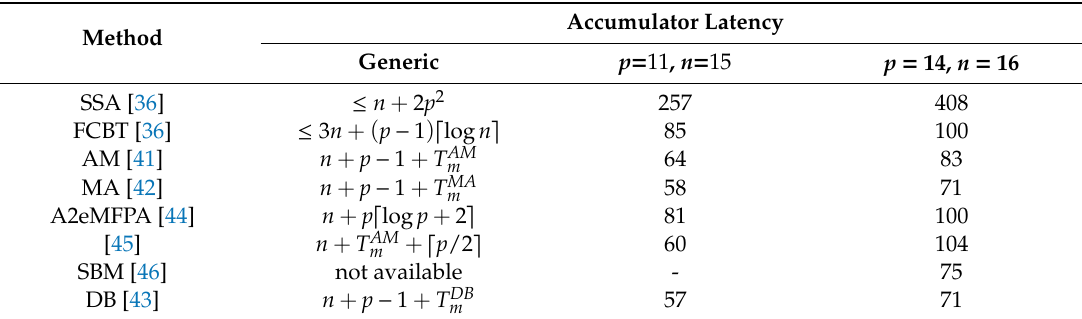
Table 1. State-of-the-art hardware accumulator